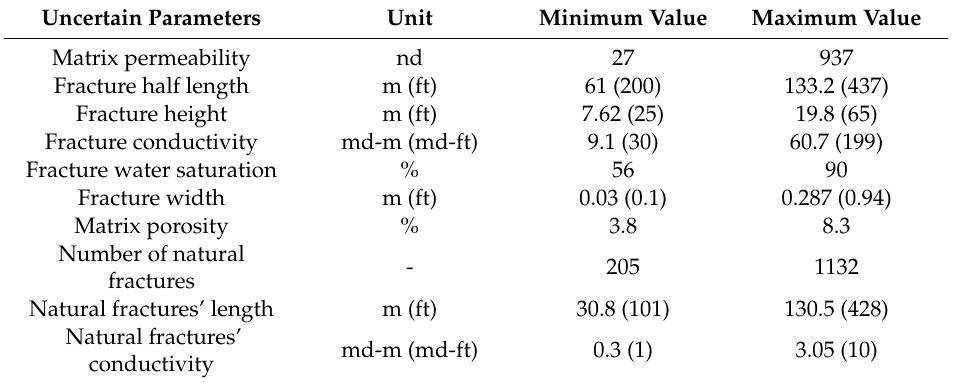
Table 2. Summary of the 10 uncertain reservoir and fracture parameters used for the well spacing